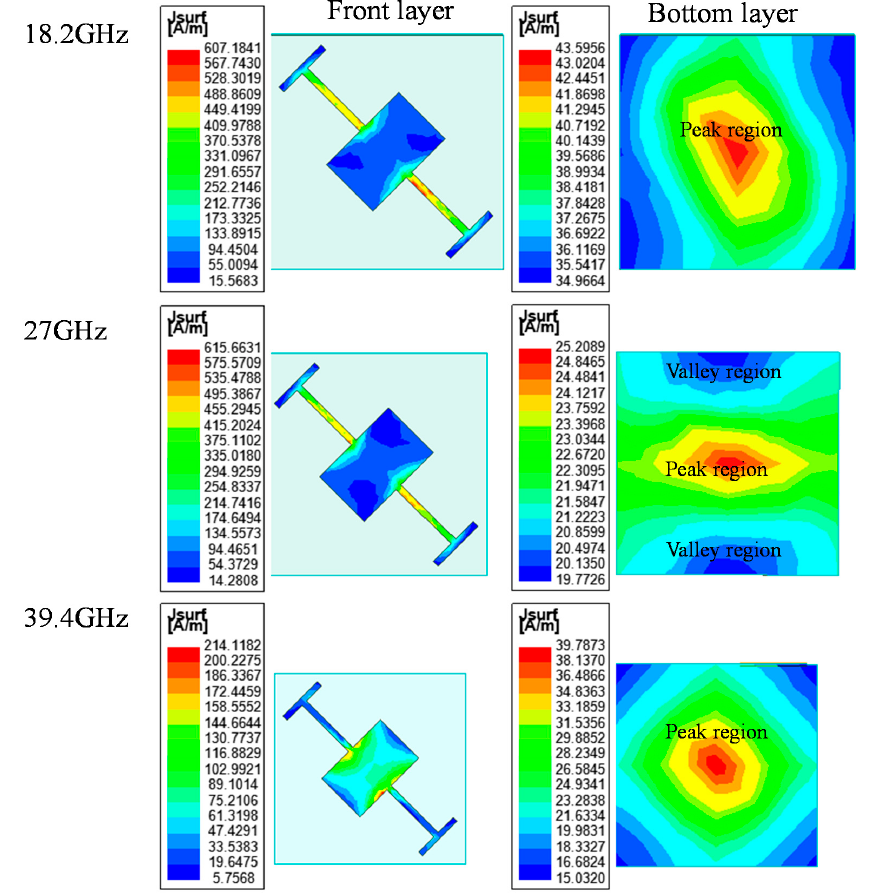
Figure 4. The current distribution at 18.2 GHz ( top row ), 27 GHz ( middle row ), and 39.4 GHz ( bottom row ). The first column is for the front layer and the second column is for the bottom layer. To investigate the sensitivity of each parameter, systematic parameter study has been conducted. The analysis is presented in Figure 5. Since the designed value for w was only